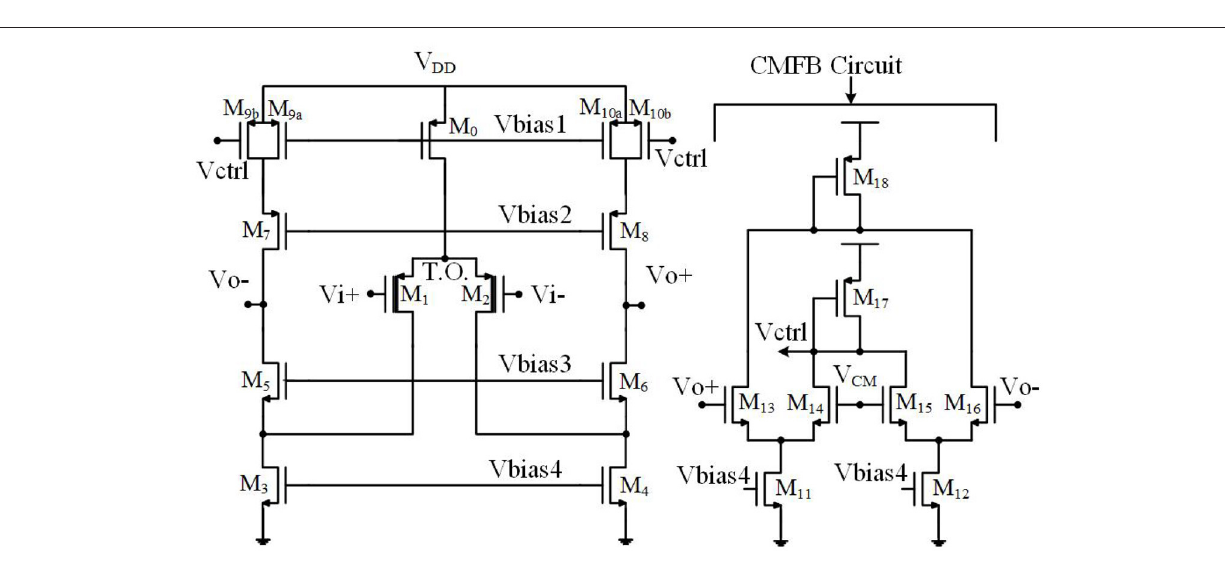
FIGURE 12 | Fully differential folded cascode OTA utilized in neural